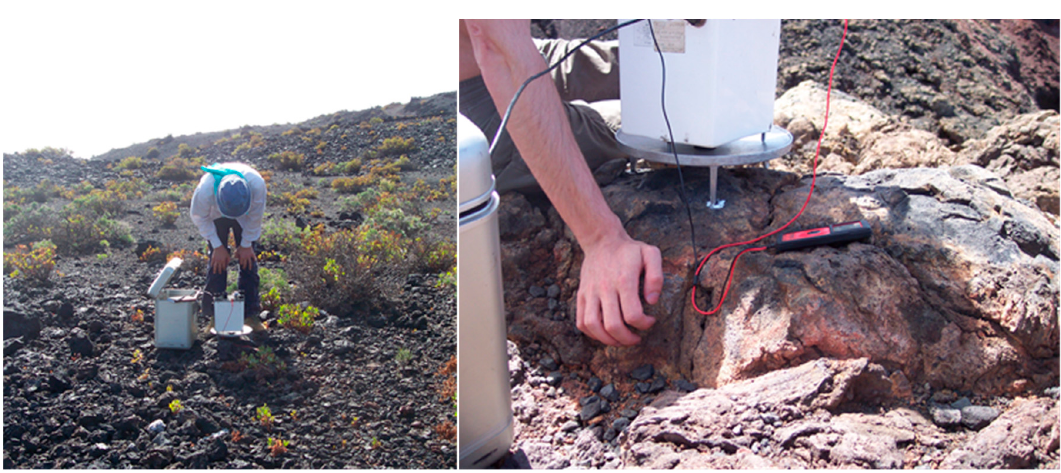
Figure 10. Photographs of the observation process, location and marking of the microgravity stations in the network on La Palma.